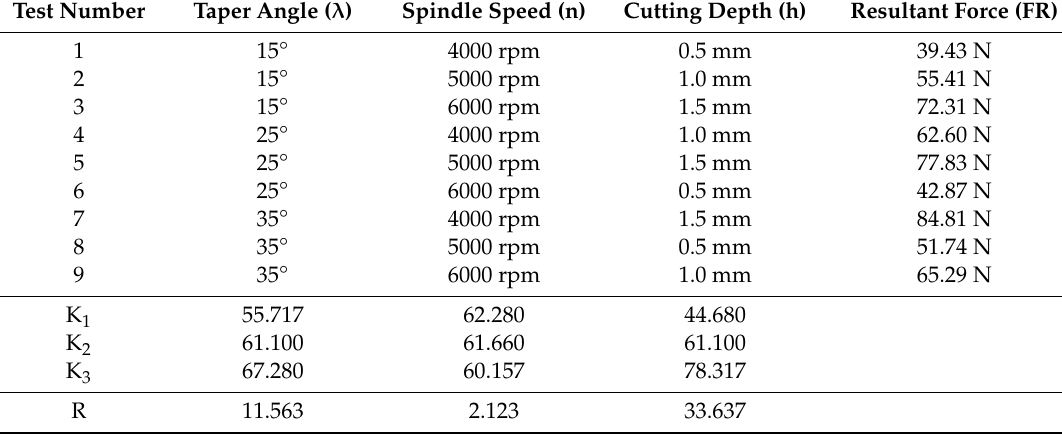
Table 4. Range analysis of resultant force (F R